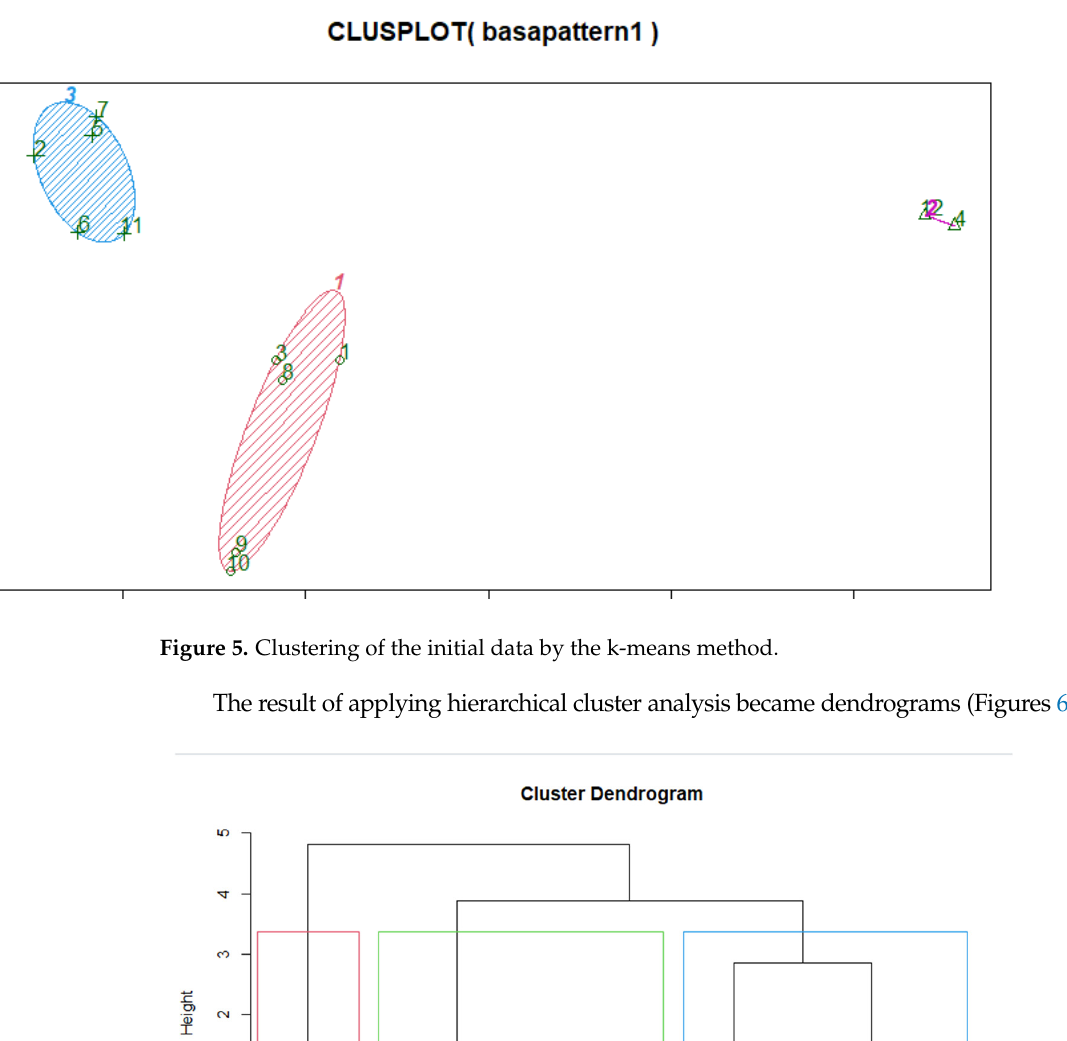
Figure 7. Dendrogram (method “ward.D2”). Analyzing the results of clustering, we conclude they are identical. Using the method of hierarchical cluster analysis, we will divide into 6 clusters, which was recommended by the “silhouette” optimization method. Figure 8 shows the result.